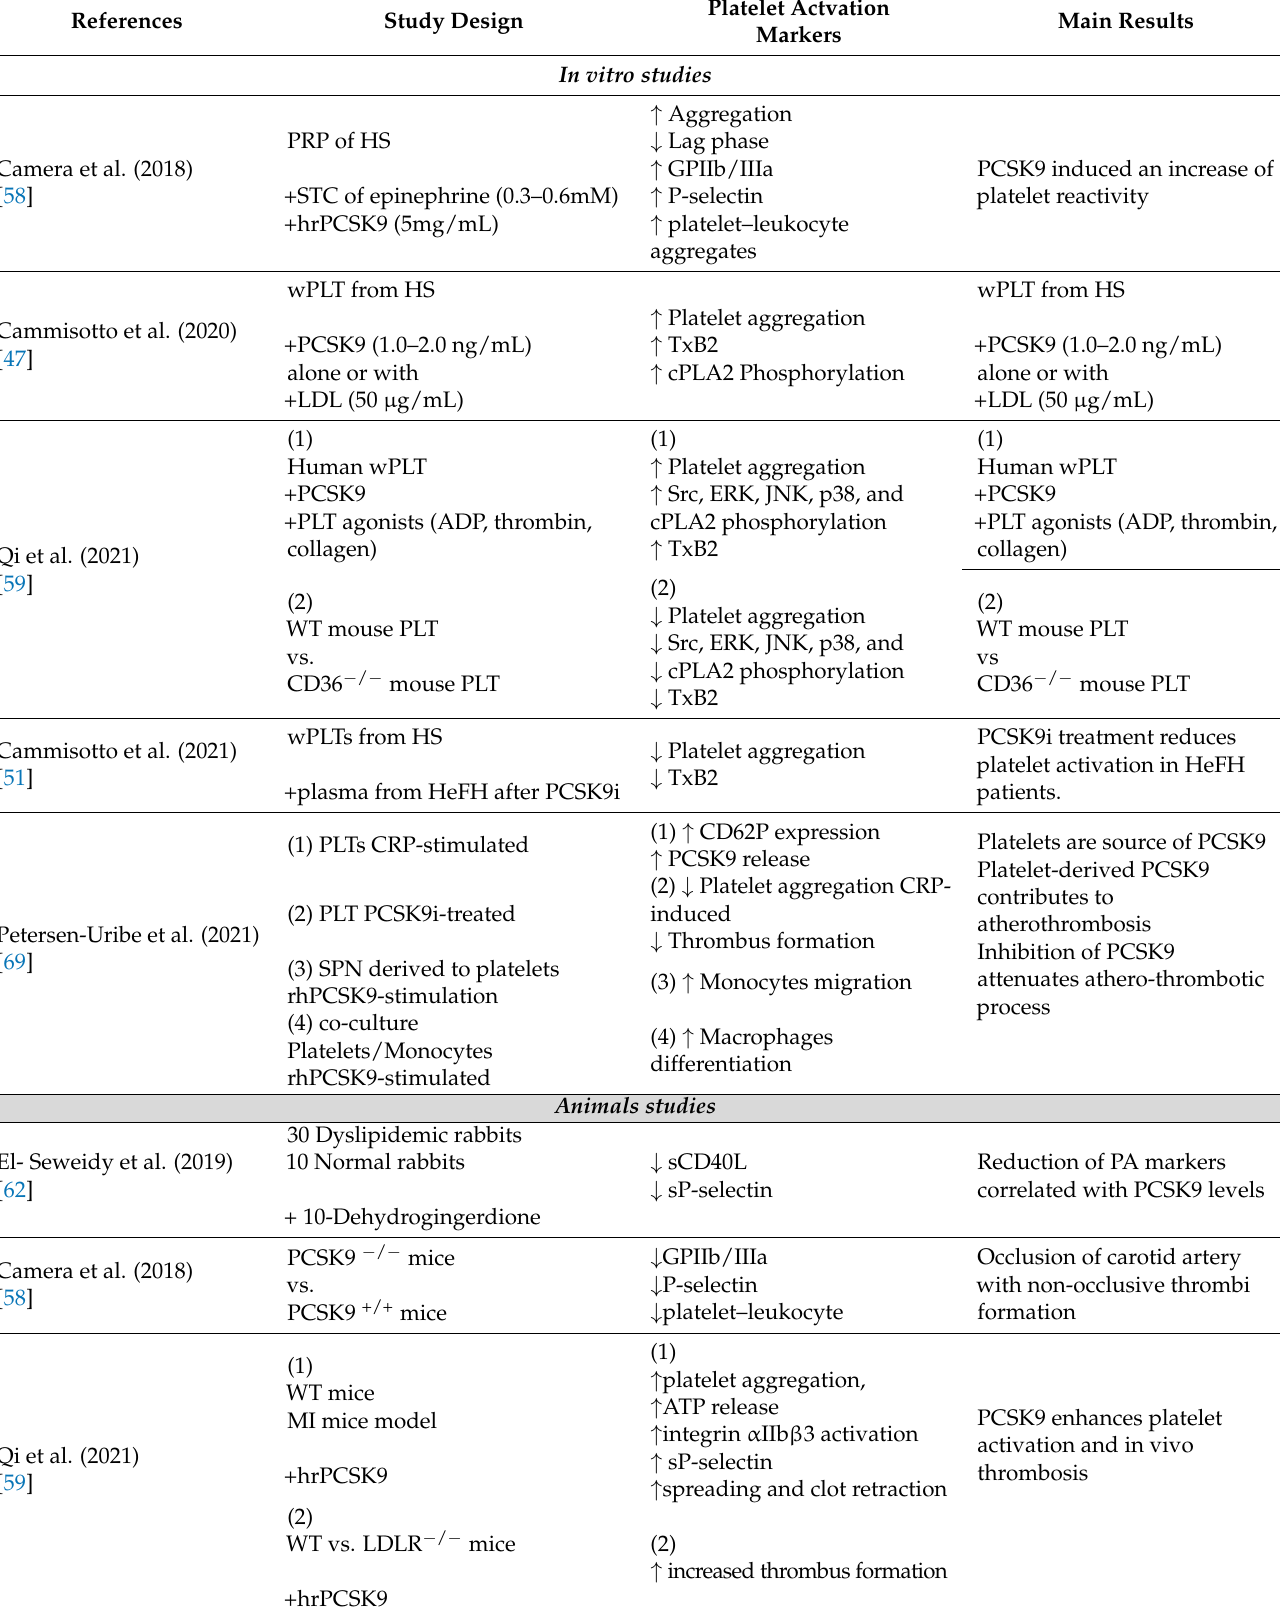
Table 1. Pre-clinical and clinical studies on PCSK9 and platelet